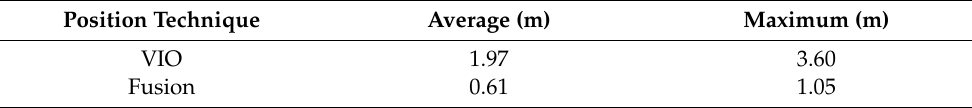
Table 3. Position error comparison of the conference room.